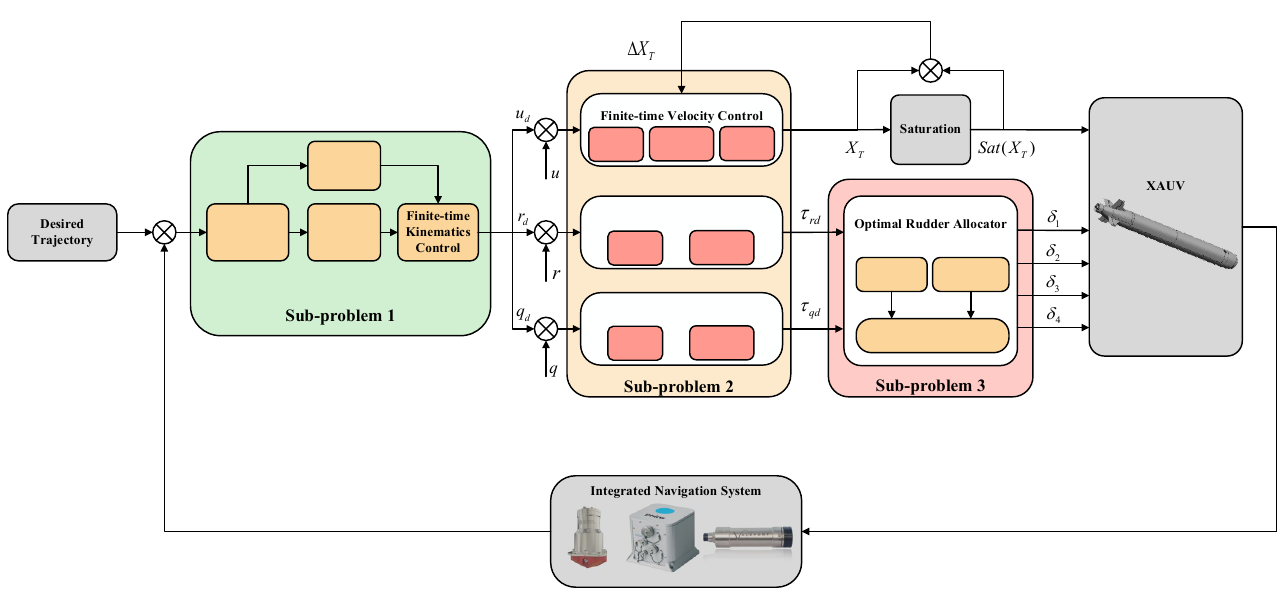
Figure 2. The proposed control